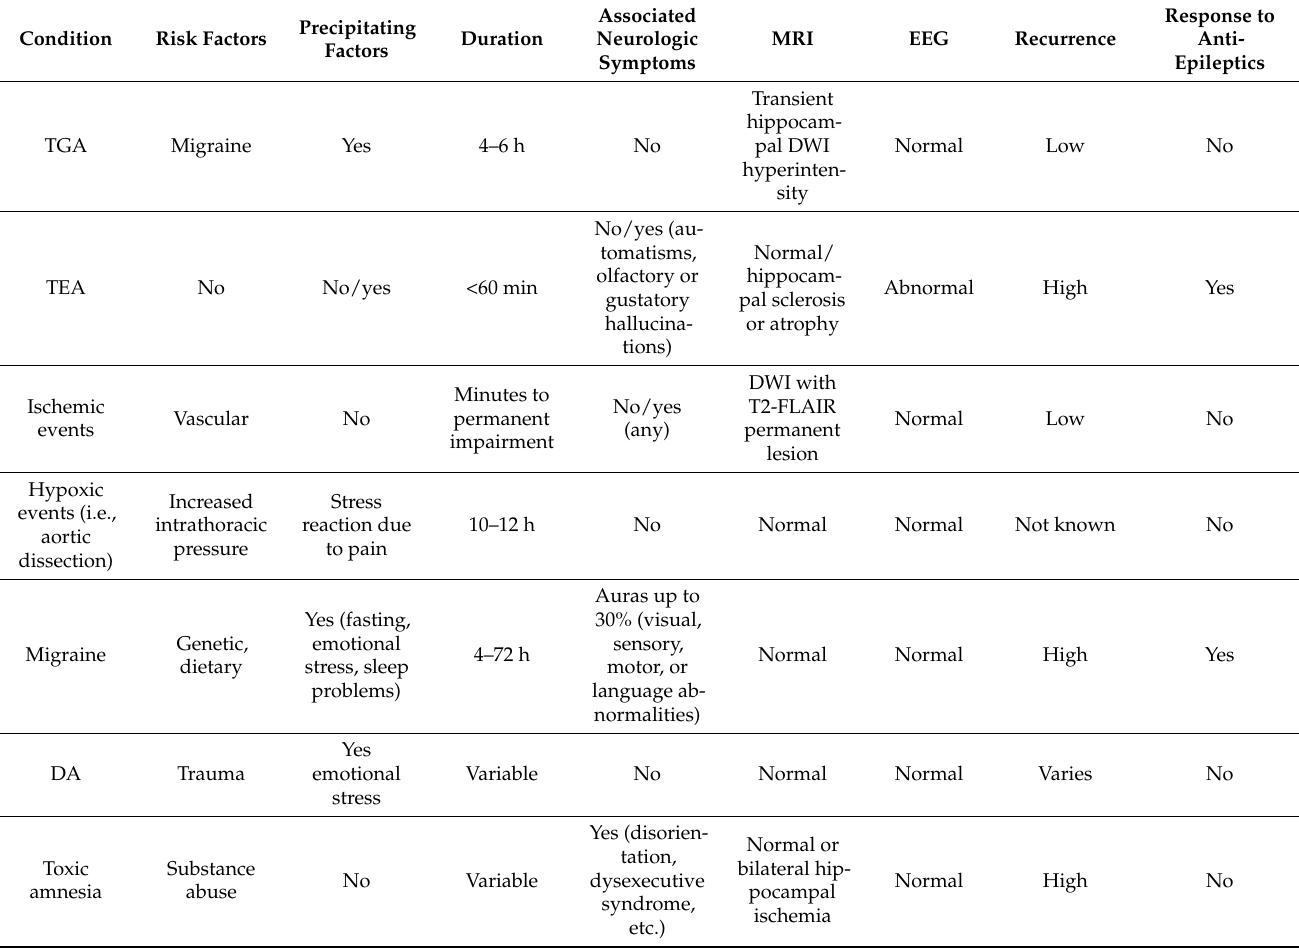
Table 3. Differential diagnosis of TGA (modified from Arena JE, et al., 2015 and Spiegel DR et al., 2017)